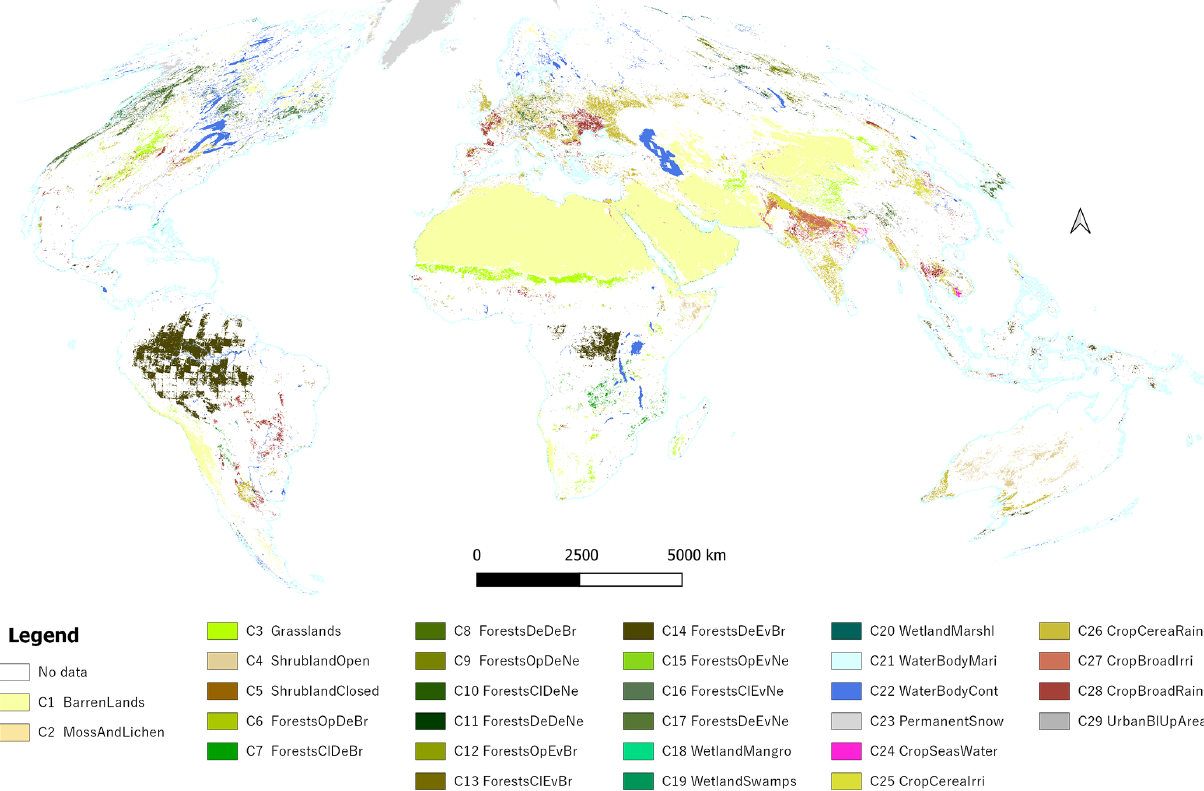
Figure 2. Distribution of the number of covered countries (Food and Agricultural Organization’s Global Administrative Unit Layers 2015 GAUL-ADM0) over the 29 LULC classes. This map combines all the final LULC class masks that were generated from the process of spatial–temporal agreement across the 15 global LULC products available in GEE. In the map’s legend we are presenting the short names of the LULC classes (their corresponding full names are presented in Table